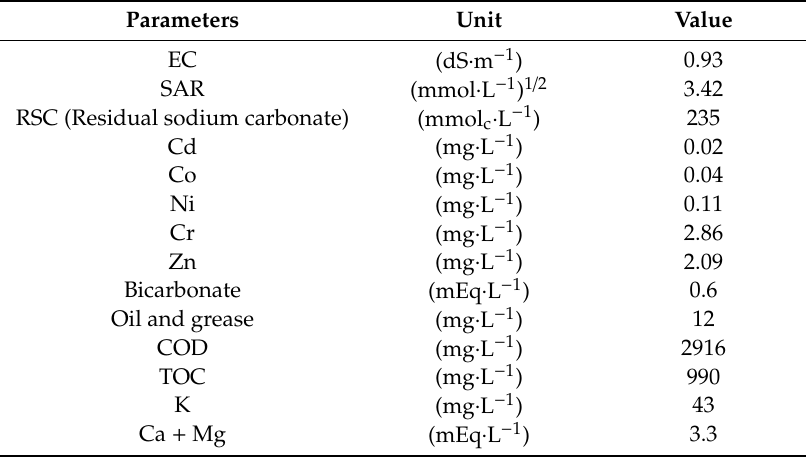
Table 2. Selected properties of the tannery wastewater used for